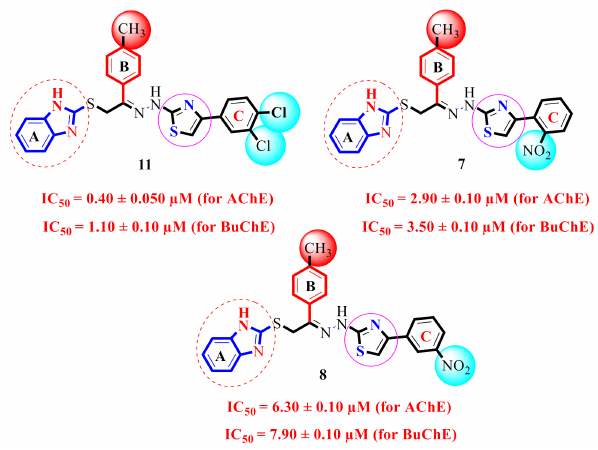
Figure 7. SAR study of scaffolds 7 , 8 and 11 .